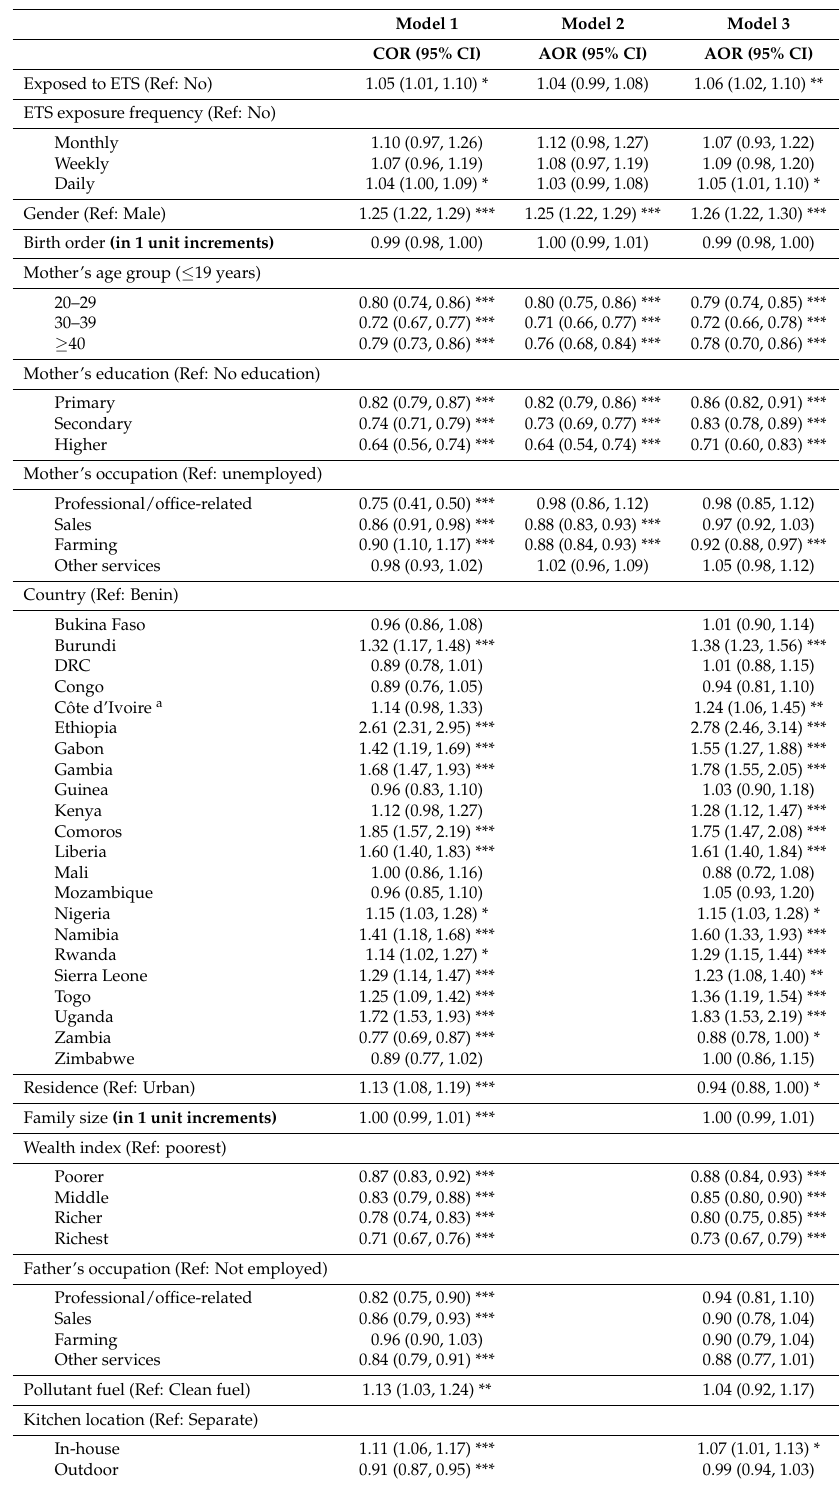
Table 2. Crude and adjusted odds ratios of logistic regression analyses for low birthweight in Africa (DHS,